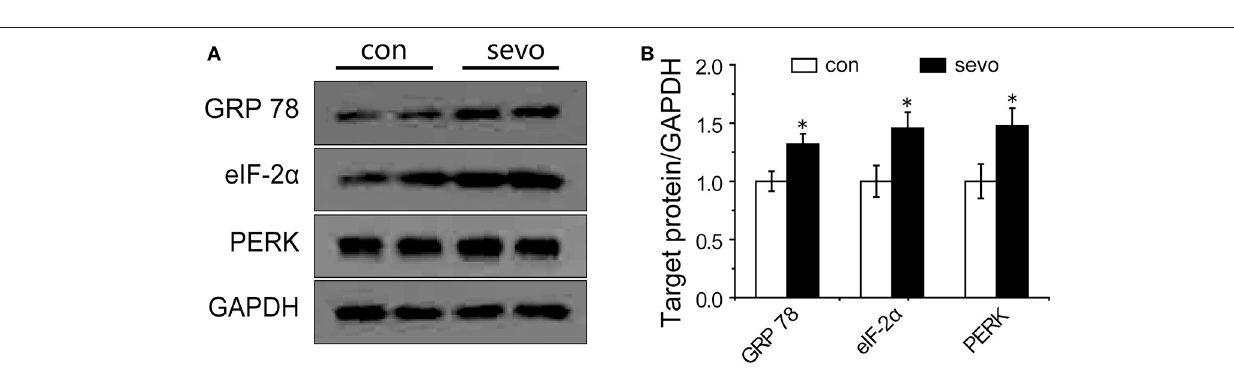
FIGURE 5 | Repeated sevoflurane exposure increased the expression of GRP 78, PERK, and eIF-2 α . (A) Representative samples showing the expression levels of GRP 78, PERK, and eIF-2 α in the hippocampi of the control group and the sevoflurane group; (B) Densitometric analysis of GRP 78, PERK, and eIF-2 α . N = 4–6 times for each protein. Unpaired t -tests; * p < 0.05 vs. control. Data are presented as the means ±